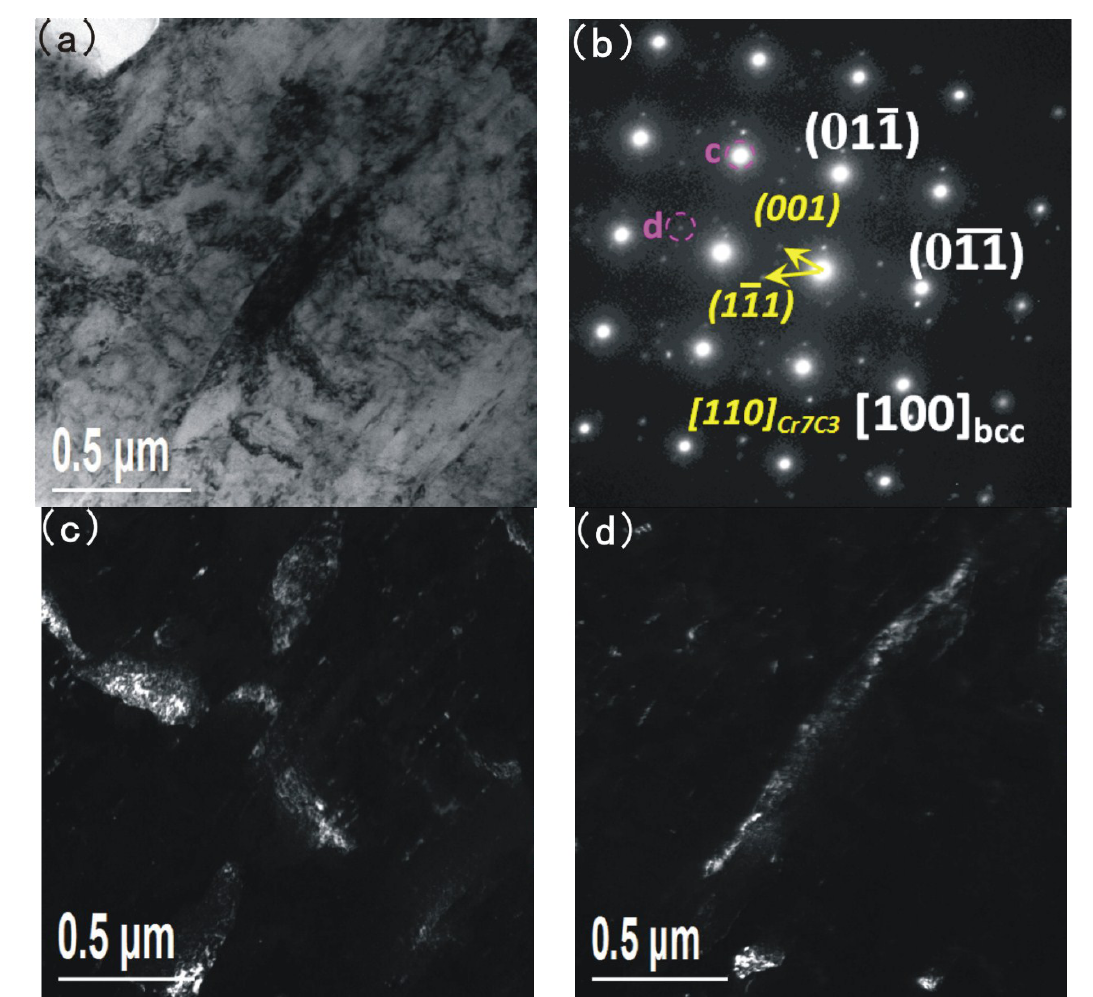
Figure 6. TEM and corresponding diffraction patterns of Cr 7 C 3 in the base metal; ( a ) bright field image; ( b ) corresponding diffraction patterns; ( c ) and ( d ) dark field